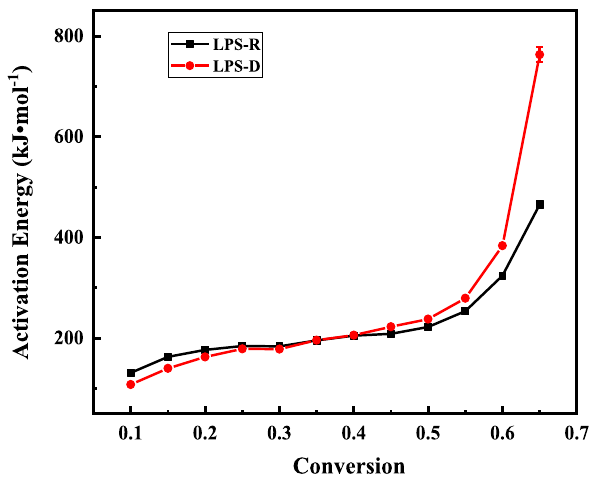
Fig. 9 Apparent activation energy of LPS-R and LPS-D pyrolysis at different